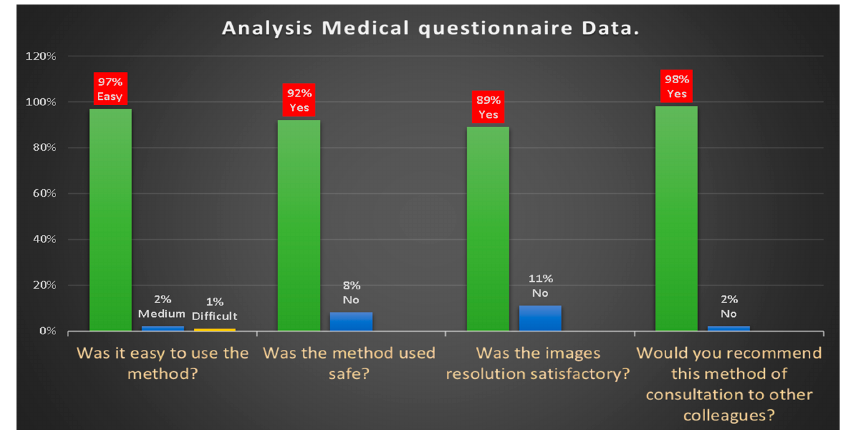
Figure 7. Analysis patient questionnaire data.